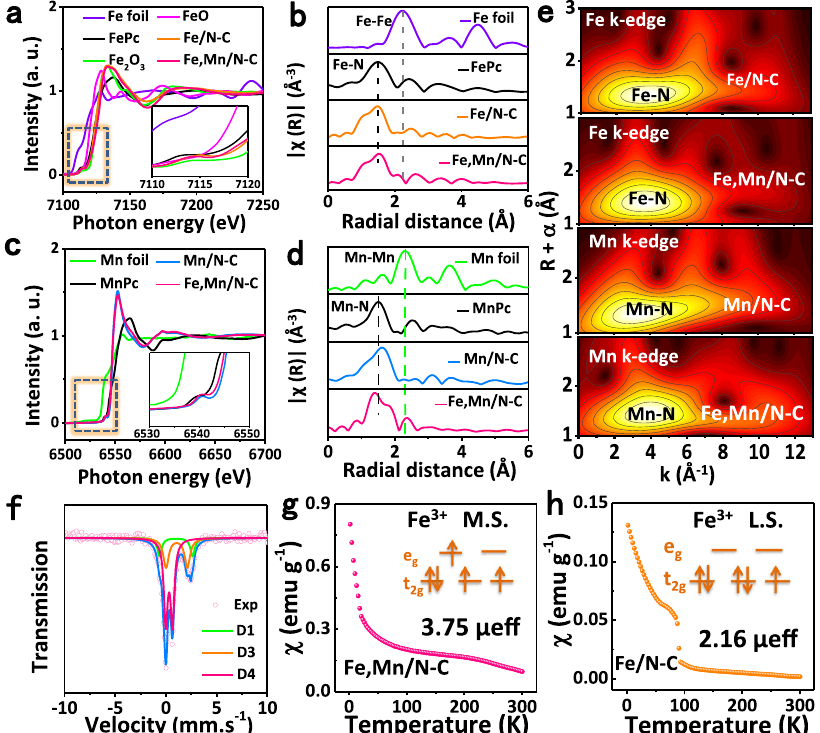
Fig. 2 XAS and 57Fe Mössbauer spectroscopy and Magnetic susceptibility of the catalysts. a Fe K-edge XANES and b Fourier-transform EXAFS spectra of Fe,Mn/N – C and reference samples. c Mn K-edge XANES and d Fourier-transform EXAFS spectra of Fe,Mn/N – C and reference samples. e Wavelet transform of the k 3 -weighted EXAFS data of Fe,Mn/N – C, Fe/N – C, and Mn/N – C. f Room-temperature 57 Fe Mossbauer spectrum of Fe,Mn/N – C. Magnetic susceptibility of g Fe,Mn/N – C, h Fe/N – C (M.S. represents medium-spin, L.S. represents